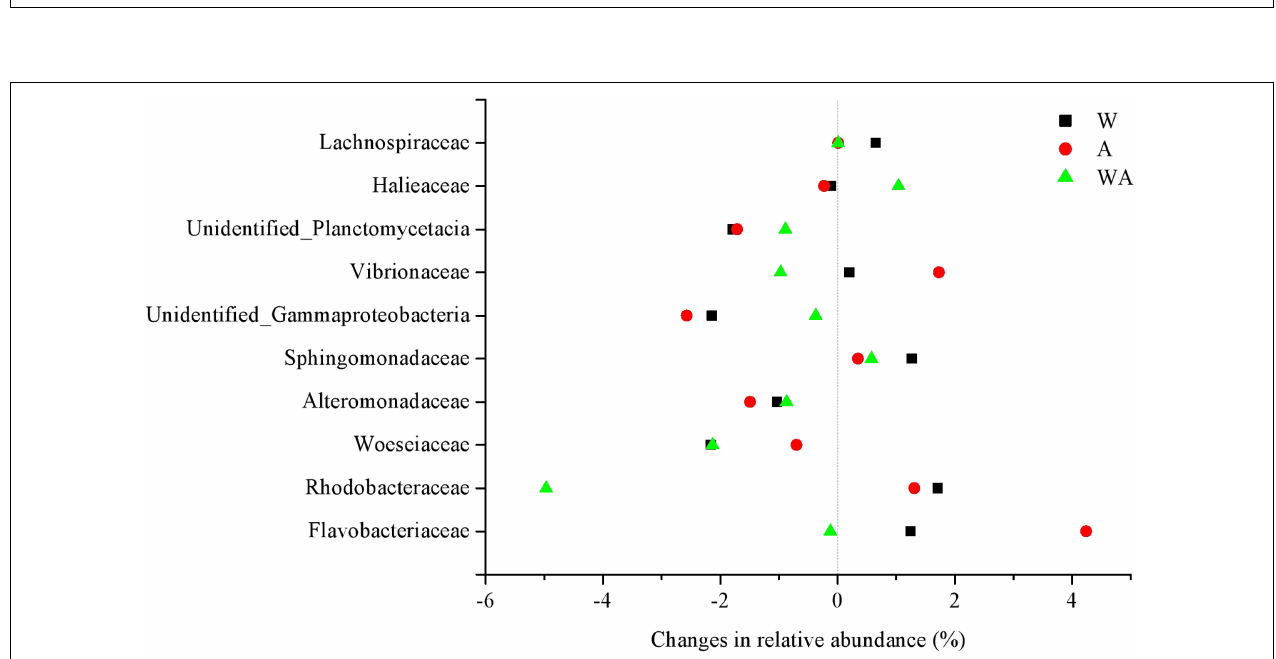
FIGURE 2 | Changes in relative abundance of the dominant families compared to the control group in different treatments in all periods (on average,%). W, warming treatment; A, acidification treatment; WA, acidification and warming treatment. The data were on average from samples in all periods (20, 43, and 72 days).